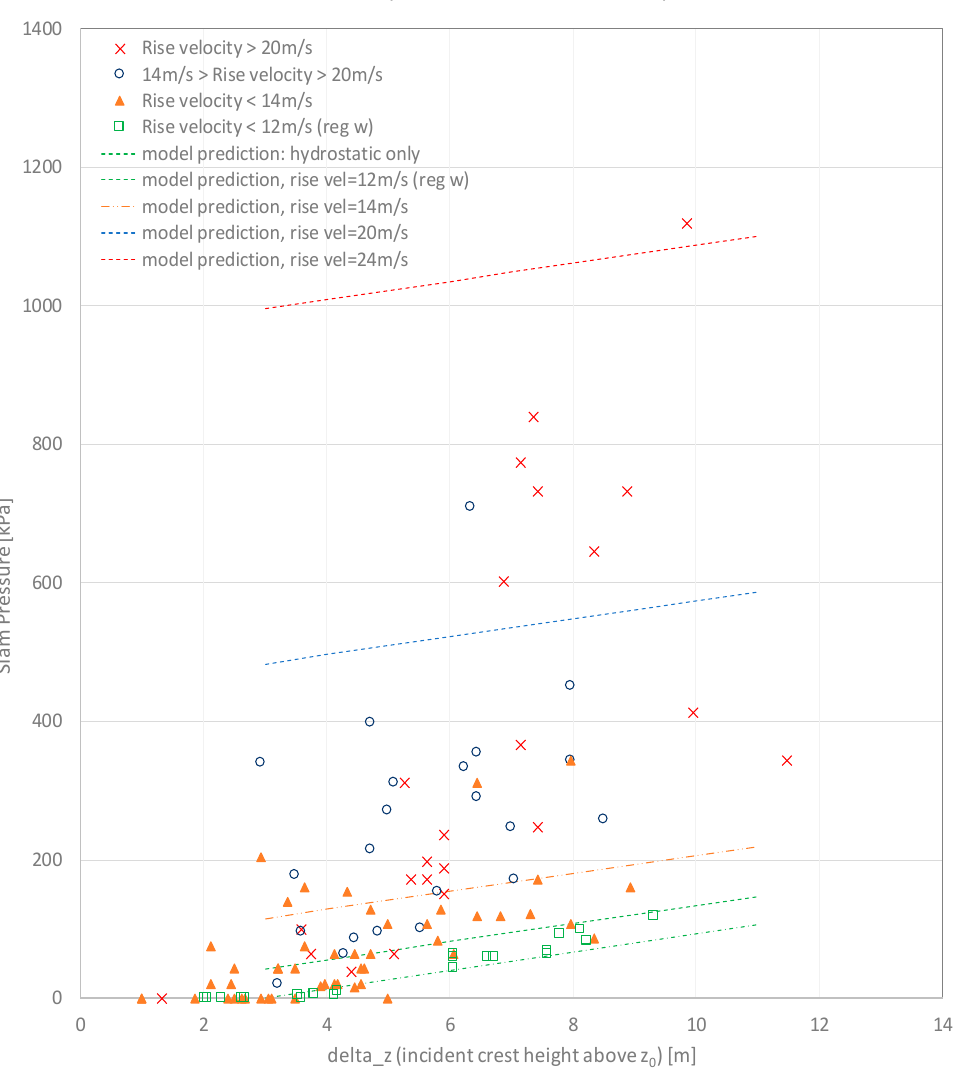
Figure 14. Correlation between measured local slamming pressure peaks and corresponding incident crest height above reference level z 0 . Here, z 0 = 15 m for water depth 151.6 m and 16.5 m for water depth 150.1 m. Estimates from simple theoretical model Equation (5) are also indicated.